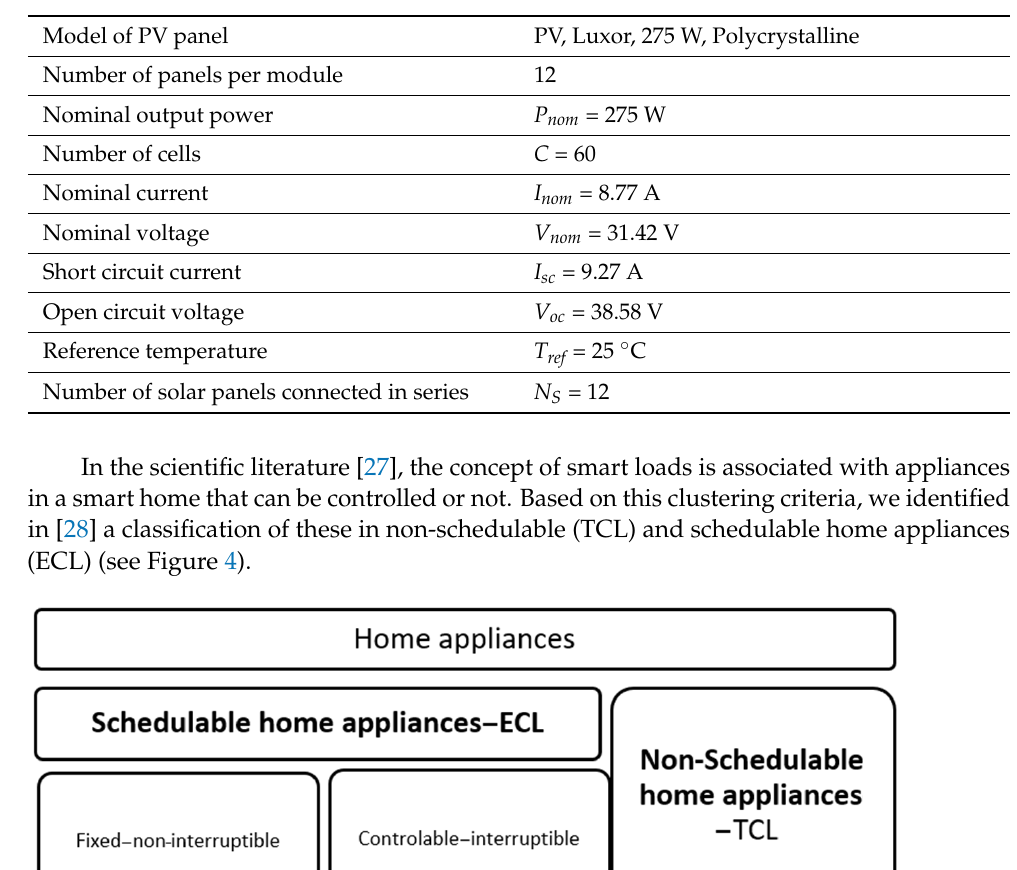
Figure 3. Connection scheme for electricity generation system on the AC network. Table 1. Photovoltaic panels’ technical characteristics.